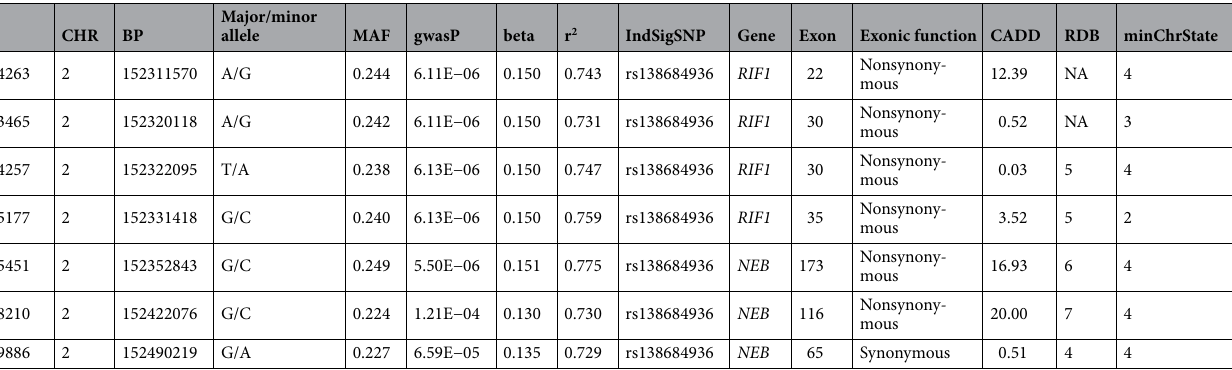
Table 2. Exonic variants in the genomic loci associated with the SMI and in LD (r 2 > 0.6) with the independent genome-wide significant SNPs. SNP p-values were computed using the linear regression model of additive allelic effects in PLINK (N = 2046 individuals). See “Methods” for the definition of independent significant SNPs (IndSigSNP). rsID rs number of the SNP, CHR chromosome, BP base-pair position on hg19, MAF minor allele frequency, gwasP SNP p-value for the SMI GWAS, CADD combined annotation dependent depletion (CADD) computed based on 63 annotations. The higher the score, the more deleterious the SNP, RDB RegulomeDB score, which is a categorical score (from 1a to 7). 1a is the highest score for SNPs with the most biological evidence to be a regulatory element, minChrState the minimum 15-core chromatin state across 127 tissue/cell